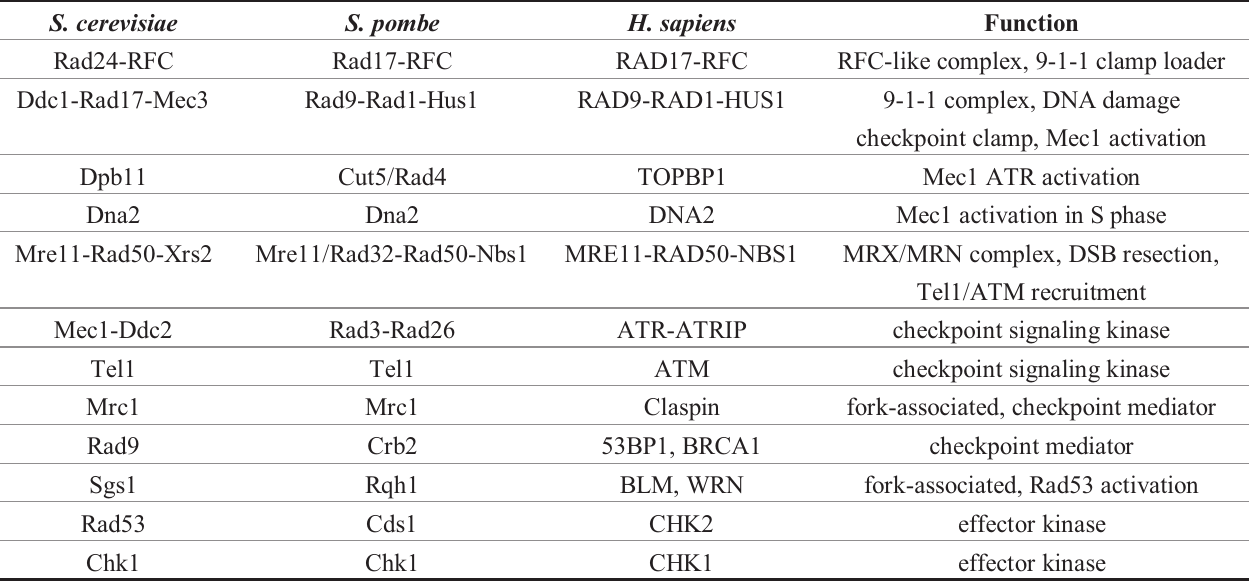
Table 1. Conserved checkpoint proteins and their